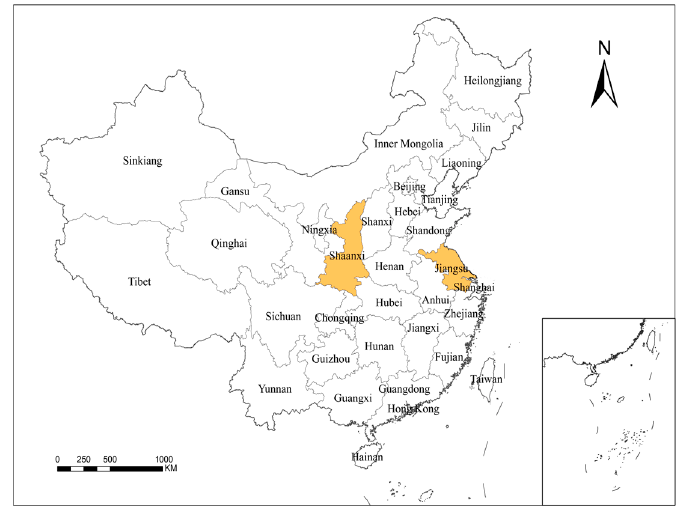
Figure 2. The location of the research area.